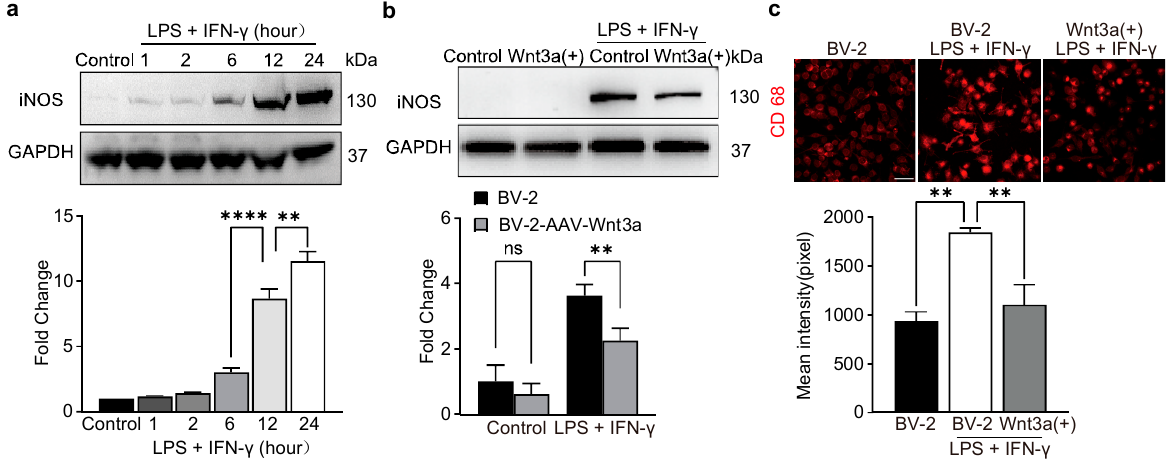
Figure 3. Wnt3a suppressed LPS/IFN- γ -induced upregulation of iNOS and CD68 in BV-2 cells. ( a ) Western blot showing the time course of level of iNOS. Top, representative bands. Bo tt om, data summary. One-way ANOVA, F (5, 12) = 107.5, **** p < 0.0001, ** p = 0.0056, n = 3. ( b ) Western blot showing expression of iNOS. Left, representative bands. Right, data summary. Two-way ANOVA, ** p = 0.0072, n = 3. ( c ) Immuno fl uorescence showing expression of CD68. Top, representative pic- tures. Bo tt om, data summary. Scale bar, 50 µm. One-way ANOVA, F (2, 6) = 13.25, **** p < 0.0001, n = 3.